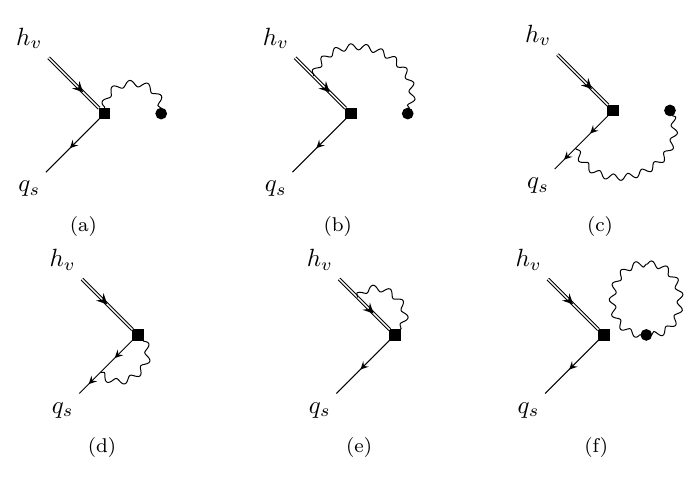
Figure 1 . O ( α em ) correction to the soft function. The square denotes the insertion of the finite- distance Wilson line [ tn − , 0] ( q ) with charge Q q and the dot the insertion of the product of soft QED Wilson lines S † ( Q M 1 ) n S † ( Q M 2 ) n −